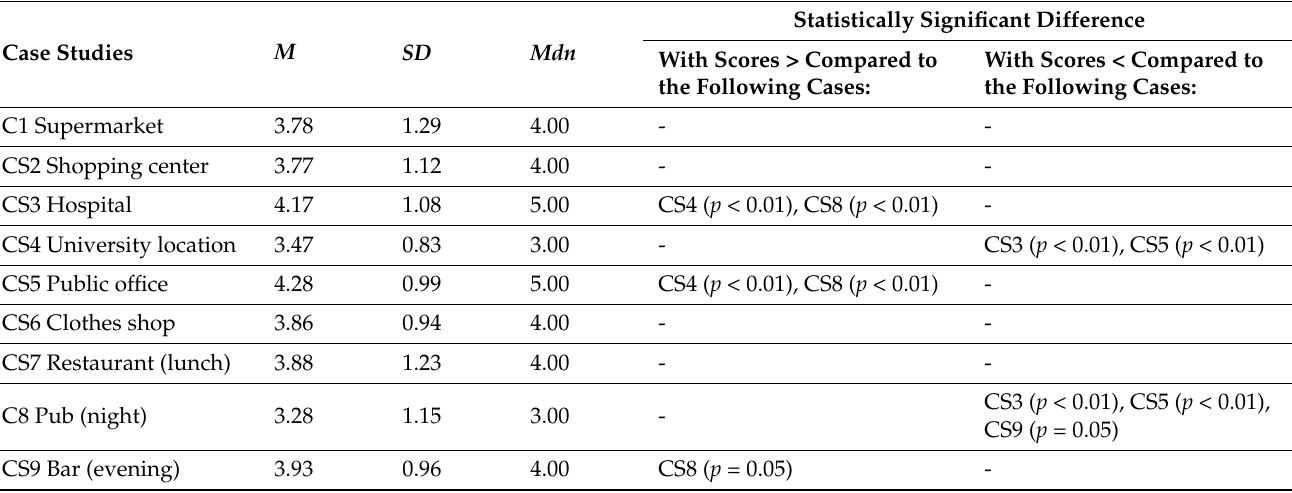
Table A21. Table shows the statistically significant differences ( p (BH)) that emerged from the comparison of item 19 in the different case studies (CS1–CS9). In the table is also reported the mean ( M ), the standard deviation ( SD ) and the median ( Mdn ). Own